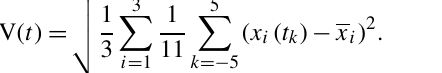
variances of the three ensemble